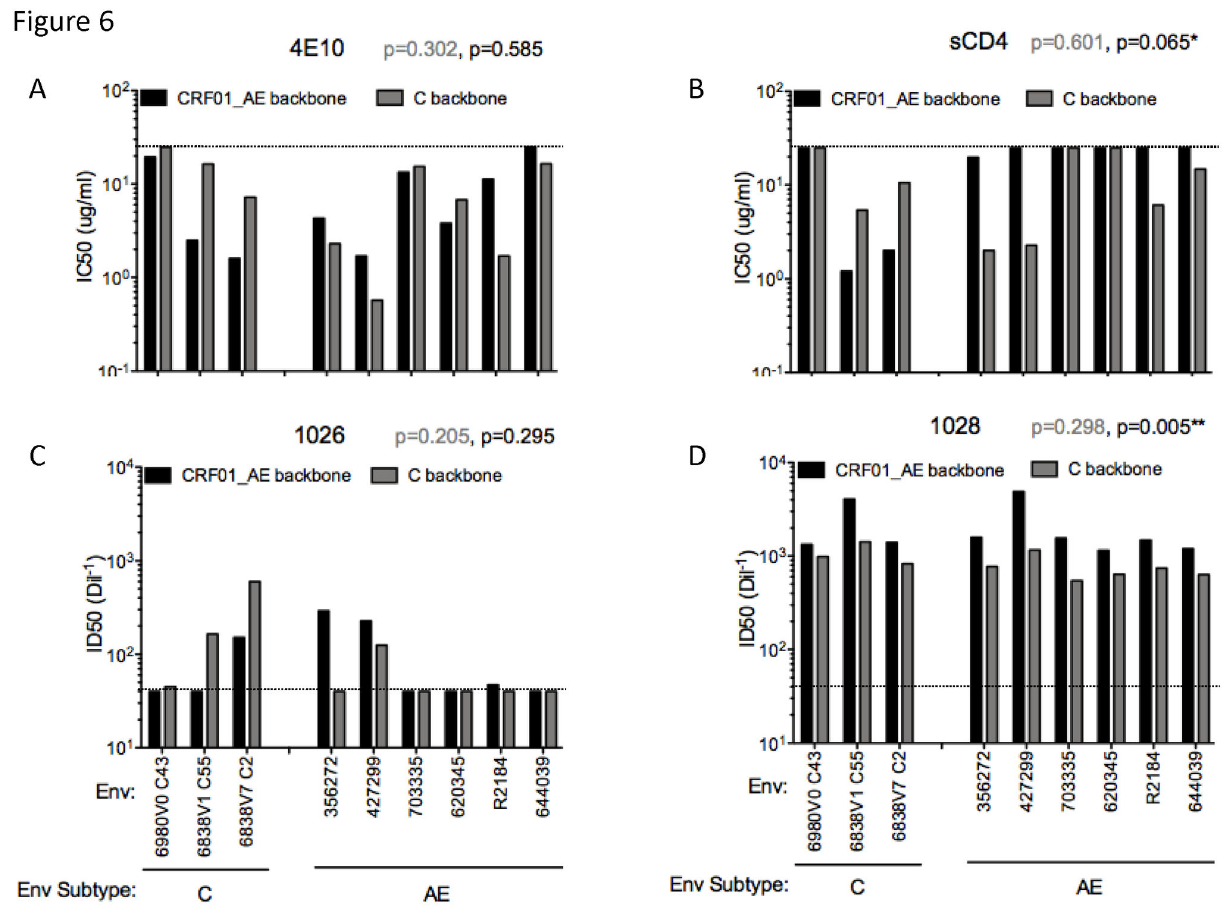
Figure 6. Neutralization sensitivity of Env expressed in subtype-matched vs mismatched backbones. Envs from three subtype C and six CRF01_AE isolates were exchanged into both the subtype C ETH2220.LucR and the CRF01_AE CM235.LucR backbones. Most of the Envs we tested were acute, except for 6838v7 and R2184. Neutralization titers for each stock were generated in TZM-bl cells using (A) 4E10 and (B) sCD4 and polyclonal plasma (C) 1026 and (D) 1028. The Y-axis represents the IC50 (A & B) or ID50 (C & D) values for each Env in both backbones. For statistical analysis, we compare, within Env subtype, neutralization sensitivity by reagent between different backbone constructs (Wilcoxon non-parametric test); p-values for C-envs are written in grey and for AE-envs in black. Horizontal lines represent the cut-off: for (A) and (B), values under the cut-off lines (25 ug/ml) represent neutralization sensitivity, when for (C) and (D) values under the cut-off (dilution 1:40) show resistance